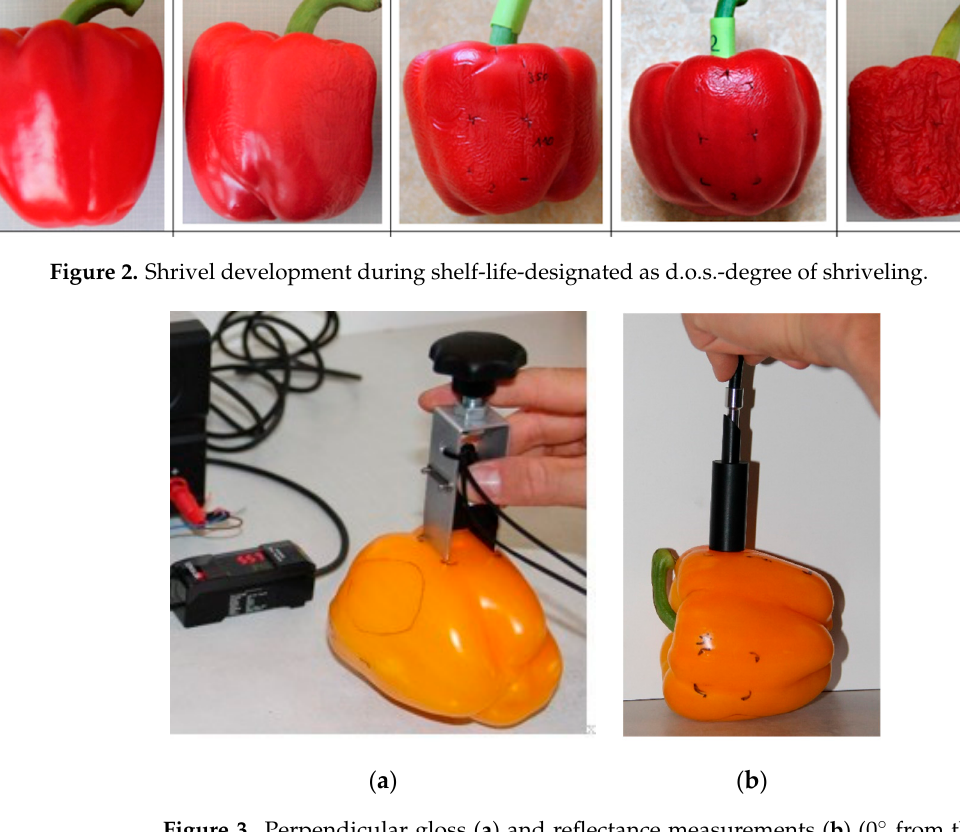
Figure 3. Perpendicular gloss ( a ) and reflectance measurements ( b ) (0° from the normal) with a portable luster sensor and spectrometer with the measured spots marked on the specimen; the same marked spots and fruit were used for all measurements in this